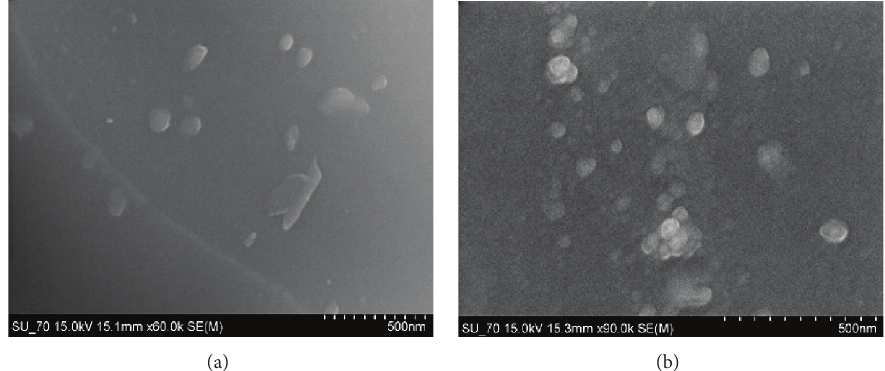
F 3: SEM micrographs of the LiW-40 (a) and NaW-40 (b) samples heat-treated at 650